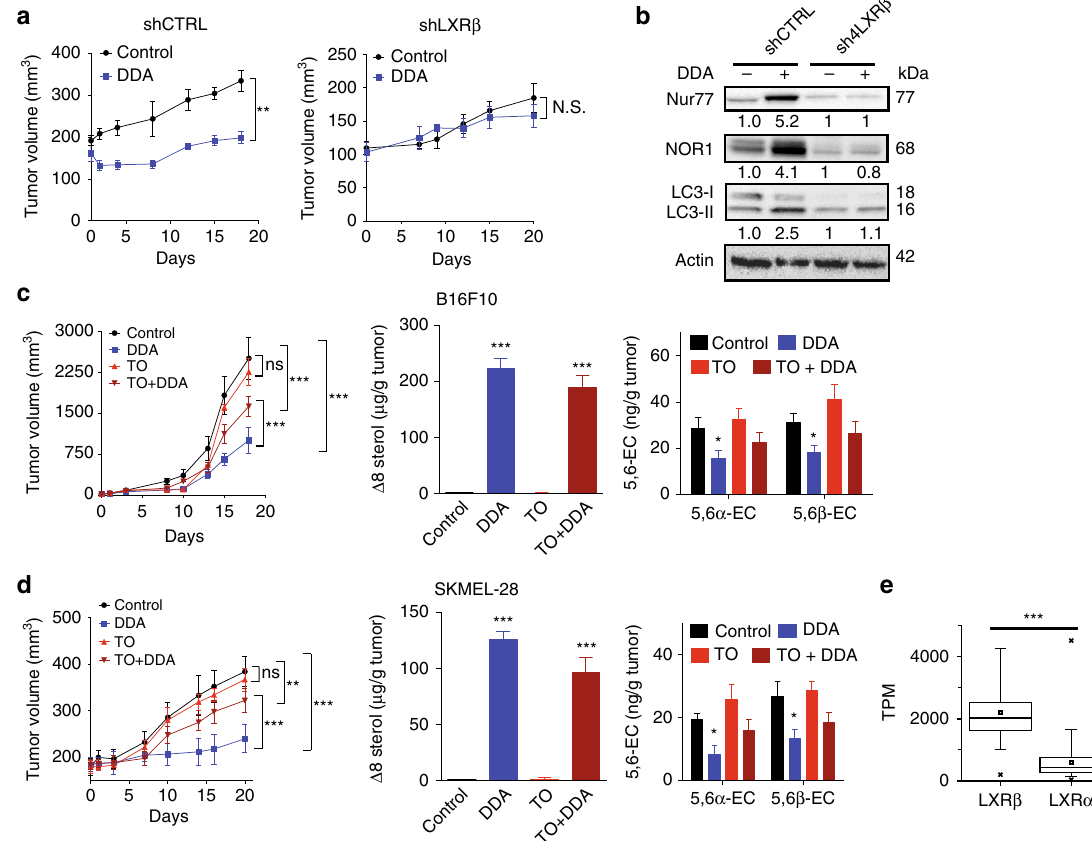
Fig. 5 The anti-melanoma action of DDA in vivo is LXR β -dependent. a Mice engrafted with SKMEL-28 cells transfected with shCTRL or sh4LXR β (10 per group) were treated with DDA (i.p. 20 mg/kg/day) or vehicle. Mean tumor volumes ± S.E.M. are shown, ** P < 0.01, analysis of variance (ANOVA). Data are representative of three independent experiments. b At the end of treatments, tumors were analyzed for Nur77, NOR1, and LC3 protein expression by immunoblotting. All images and blots are representative of three independent experiments. c, d Mice engrafted with mouse B16F10 cells or human SKMEL- 28 (10 per group) were treated with vehicle, DDA (i.p. 20 mg/kg/day), TO (i.p. 20 mg/kg/day), and DDA + TO (i.p. 20 mg/kg/day each). Mean tumor volumes ± S.E.M. are shown, ** P < 0.01, analysis of variance (ANOVA). Quanti fi cation of Δ 8-sterols and 5,6 α -EC and 5,6 β -EC in tumors were quanti fi ed by GC/MS. The results are reported as µ g Δ 8-sterols or ng 5,6-EC/g tumors. e Box plot of TCGA RNA-seq data from patients with melanoma showing that LXR β is the predominant LXR isoform expressed. *** P <